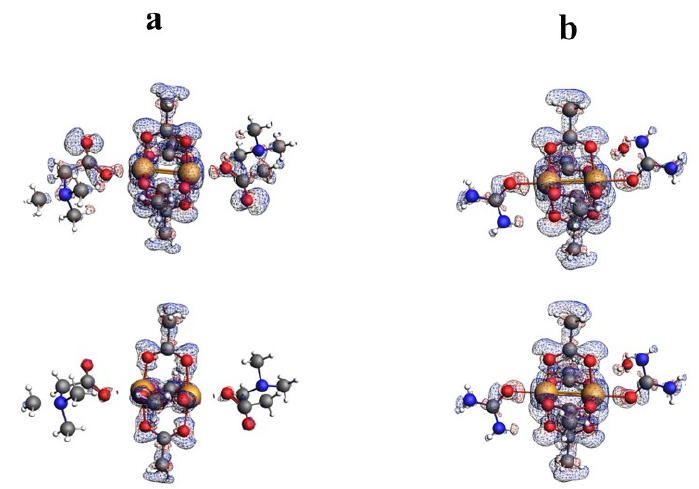
Figure 9. Fukui surfaces for QEBQIX ( a ) and ACURCU01 ( b ). Field isosurfaces have been generated at the value of 0.001. Upper row—Fukui minus, bottom row—Fukui plus.